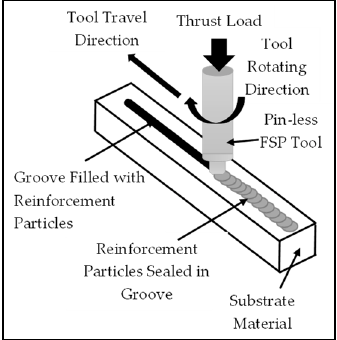
Figure 3. Schematic diagram of capping .